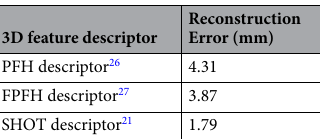
Table 2. Experimental results of replacing SHOT with other 3D descriptors in the evaluation on the Dome dataset 15 .